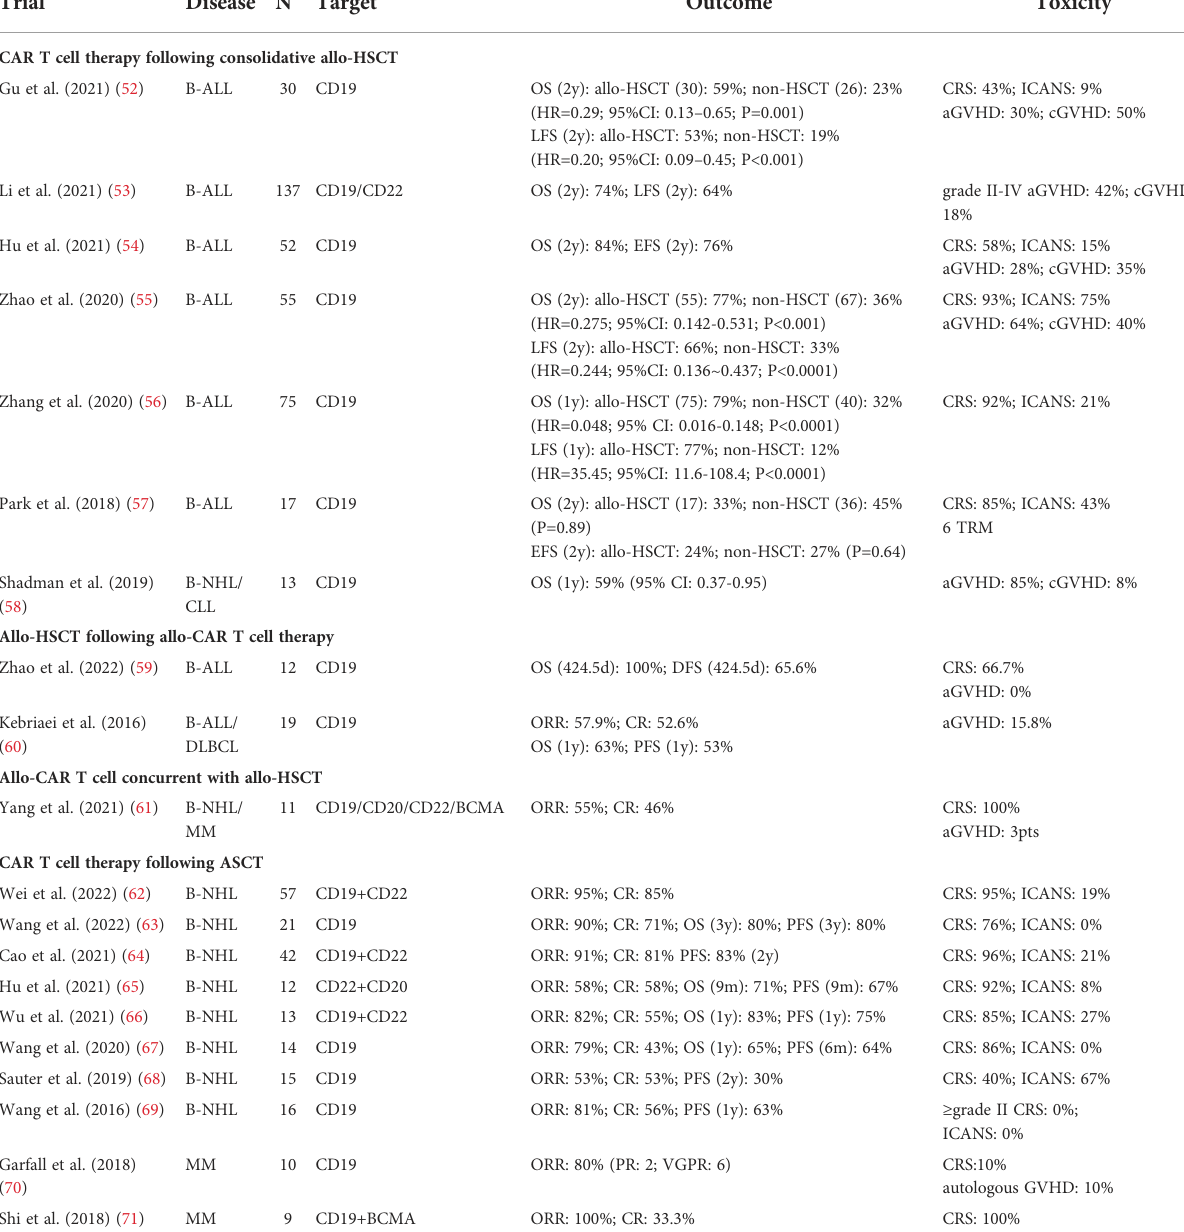
TABLE 2 Selective trials for combinations of CAR T cell therapy with HSCT. Trial Disease N Target